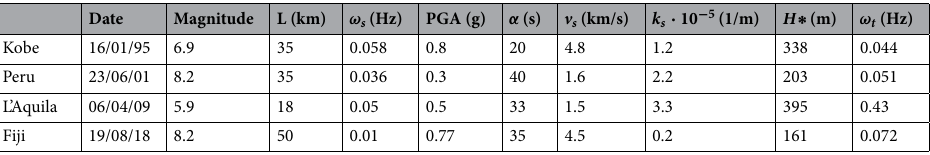
Table 1. Parameters used for the evaluation of the pressure fluctuations dispersion relations associated to 1998 Kobe, 2001 Peru, 2009 L’Aquila and 2018 Fiji earthquakes.